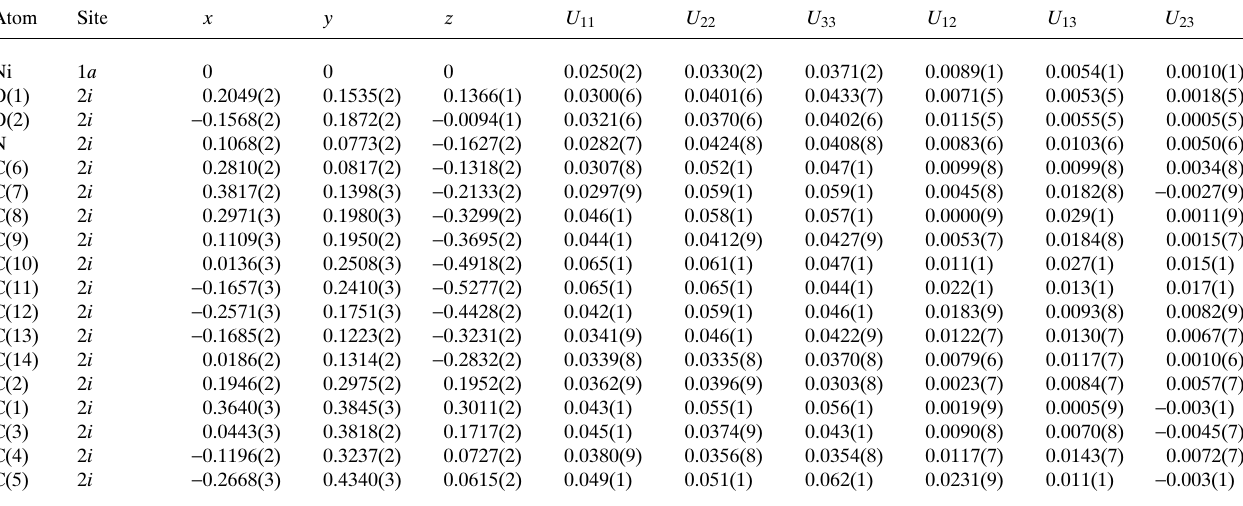
Table 3. Atomic coordinates and displacement parameters (in Å 2 )